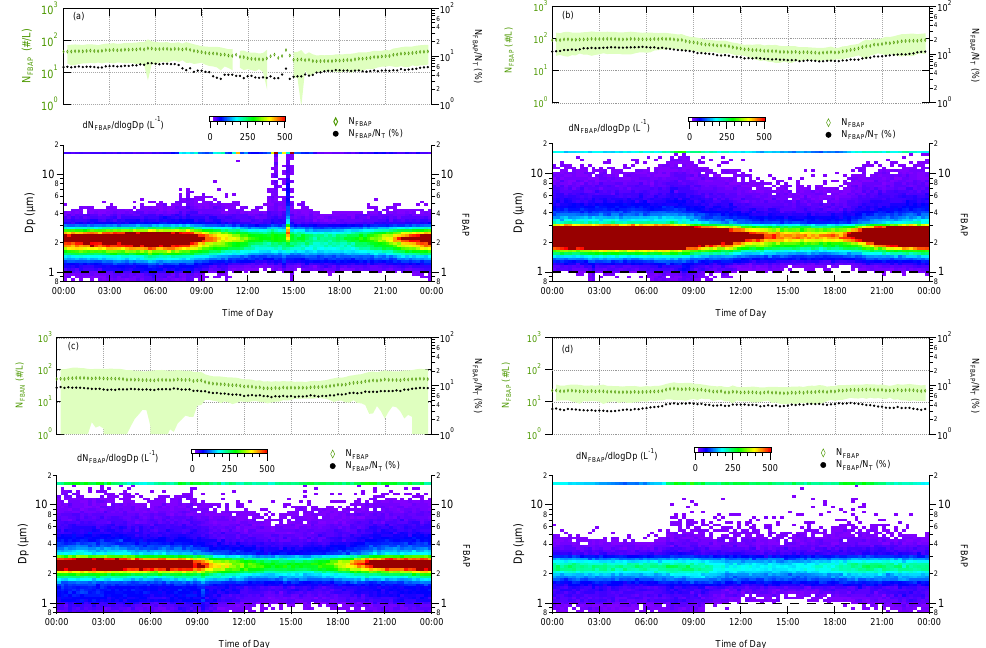
Fig. 9. WIBS-4 fluorescence data to show the diurnal changes of FBAP number concentrations and distribution for different sampling terms. The data were plotted in the same way as in Fig. 3: (a) spring, (b) summer, (c) autumn, (d) winter. The spikes on (a) around 15:00 p.m. are most probably due to some reconstruction events at and around the sampling site.